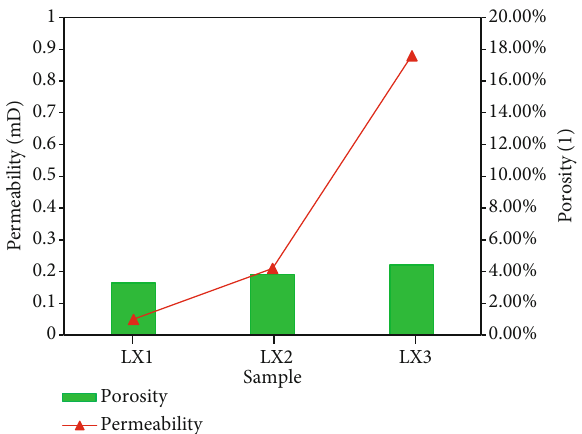
Figure 9: Permeability and porosity of the three samples.